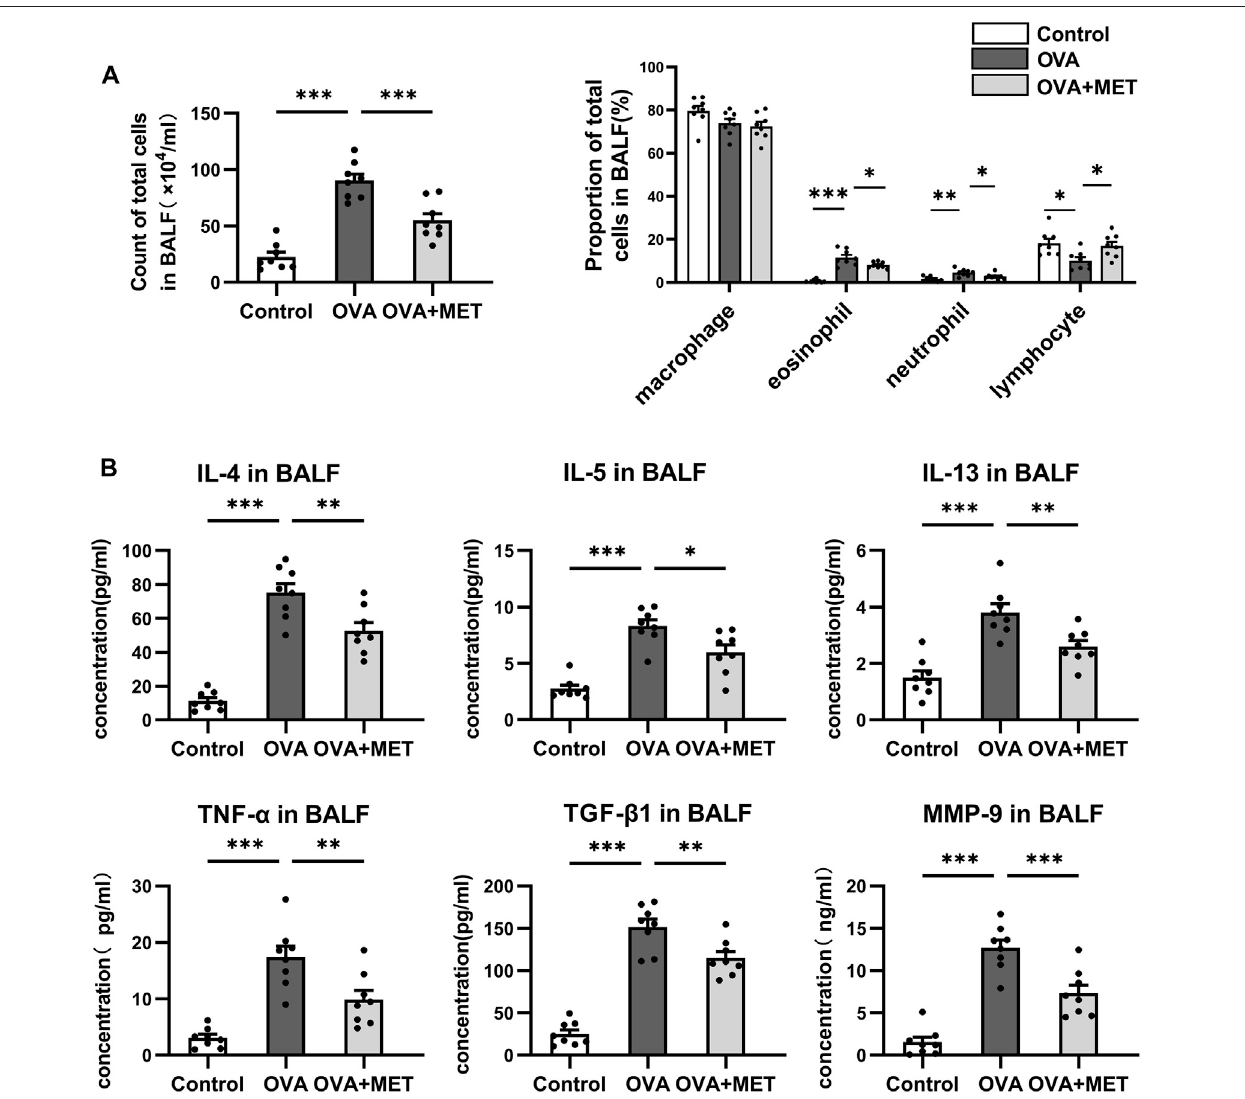
FIGURE4| MetforminreducesmultiplecytokinelevelsintheBALFfromtheasthmaticmice. (A) .Comparison oftotalcellnumbers anddifferentialcellcountsinthe BALF. (B) .Comparisonofcytokineconcentrations(IL-4,IL-5,IL-13,TNF- α ,TGF- β andMMP-9)intheBALF.Datawerepresentedasmean ± SEM.n (cid:1) 8.* p < 0.05,** p < 0.01, *** p <